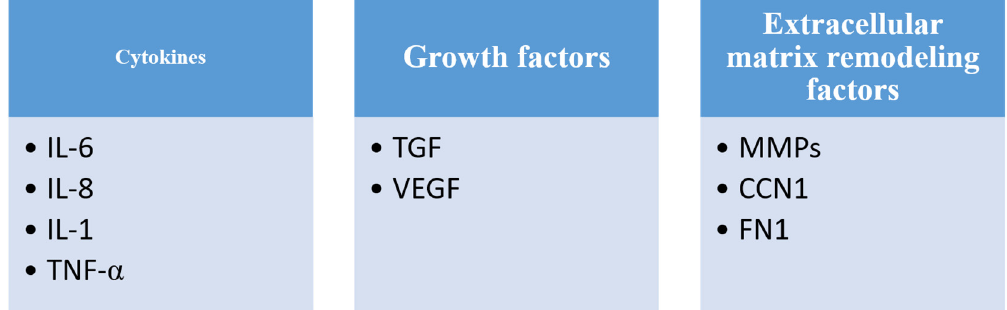
Figure 2. The components of SASP are numerous, but the most important ones are: interleukin (IL) 6, 8 and 1, tumor necrosis factor alpha (TNF- α ), transforming growth beta (TGF), vascular endothelial growth factor (VEGF), matrix metalloproteinases (MMPs), protein CCN1 and fibronectin1 (FN1).